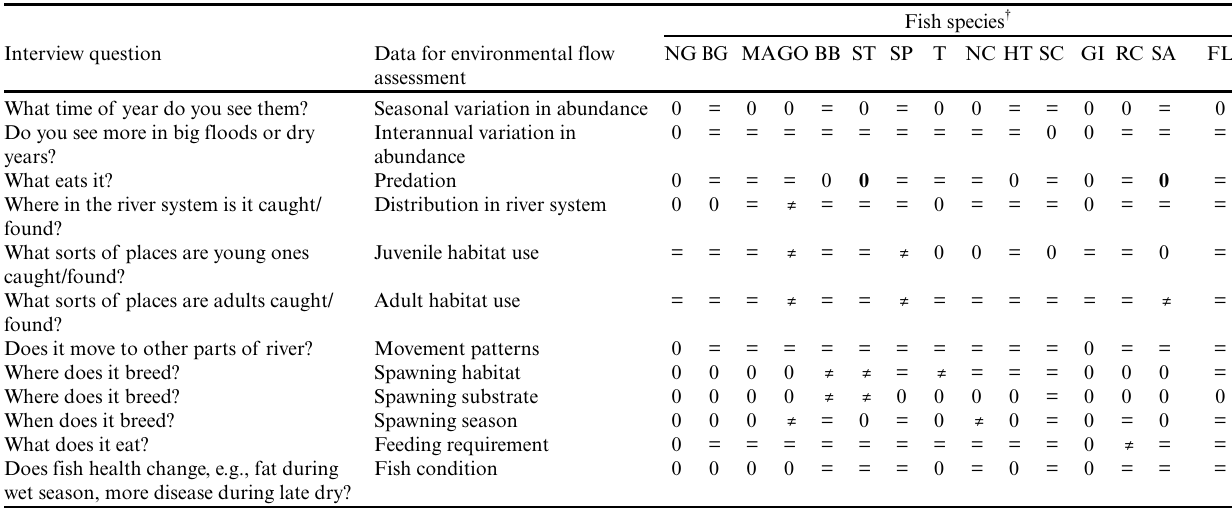
Table 1 . Similarities and differences between indigenous ecological knowledge (IEK) and scientific knowledge (SK) related to environmental flow assessments for 15 fish species from the Daly River, Northern Territory. Categories are: Congruent (=) when IEK and documented SK from either the Daly or another river system were consistent or when IEK added new knowledge that complemented or extended existing SK for the Daly River; Incongruent (≠) when IEK and documented SK are inconsistent; No knowledge (0) when there was documented SK but no IEK. The two cases for which there was no SK or IEK are shown in bold